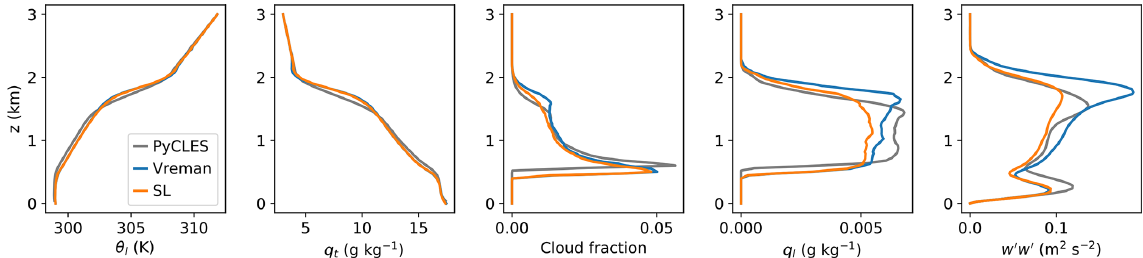
Figure 11. BOMEX. Profile of the mean state of liquid potential temperature, total specific humidity, cloud fraction, liquid water specific humidity, and variance of the vertical velocity fluctuations averaged along the last hour of the simulation. The solutions with PyCLES and ClimateMachine were calculated with effective grid resolution (cid:49)x = (cid:49)y = 100m and (cid:49)z = 40m. Results calculated with Vreman (blue lines) and SL SGS (orange lines) models in ClimateMachine are compared against results of PyCLES (grey lines) in its paired SGS modality using the SL